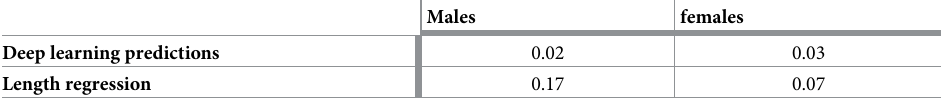
Table 3. KL-divergence. KL-divergence of the predicted age distributions with regard to the distribution of the ground